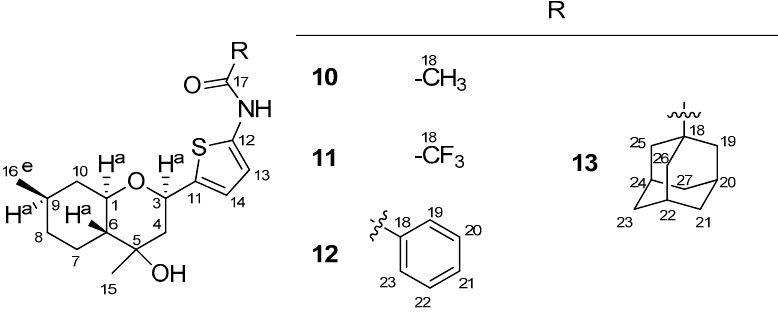
Figure 3. The numeration of the atoms of 8–13 in NMR spectra.